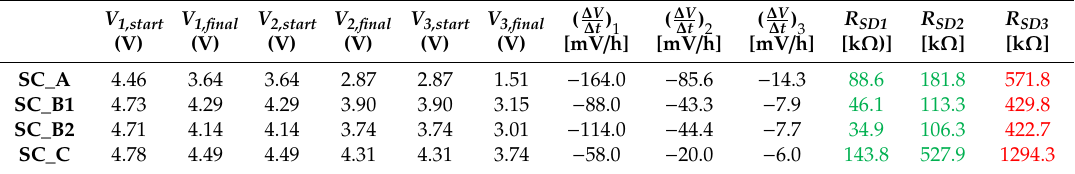
Table 2. Summarizing table with SCs’ self-discharge rates, expressed in mV / h, and self-discharge R SD resistance calculated for the three considered time intervals (SCs charged at 5 V and then kept under charge for one